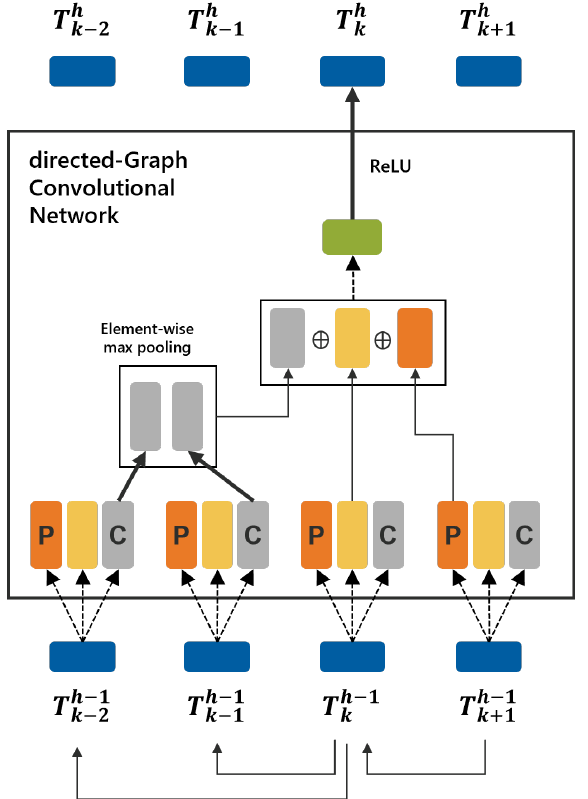
Figure 4. Example of node propagation in the h -th d -GCN